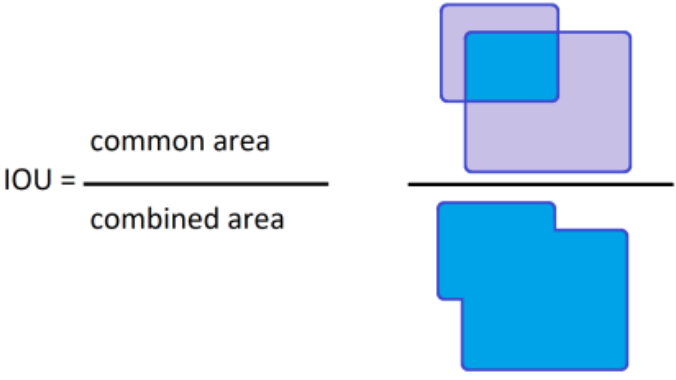
Figure 7. Schematic of the IOU calculation.